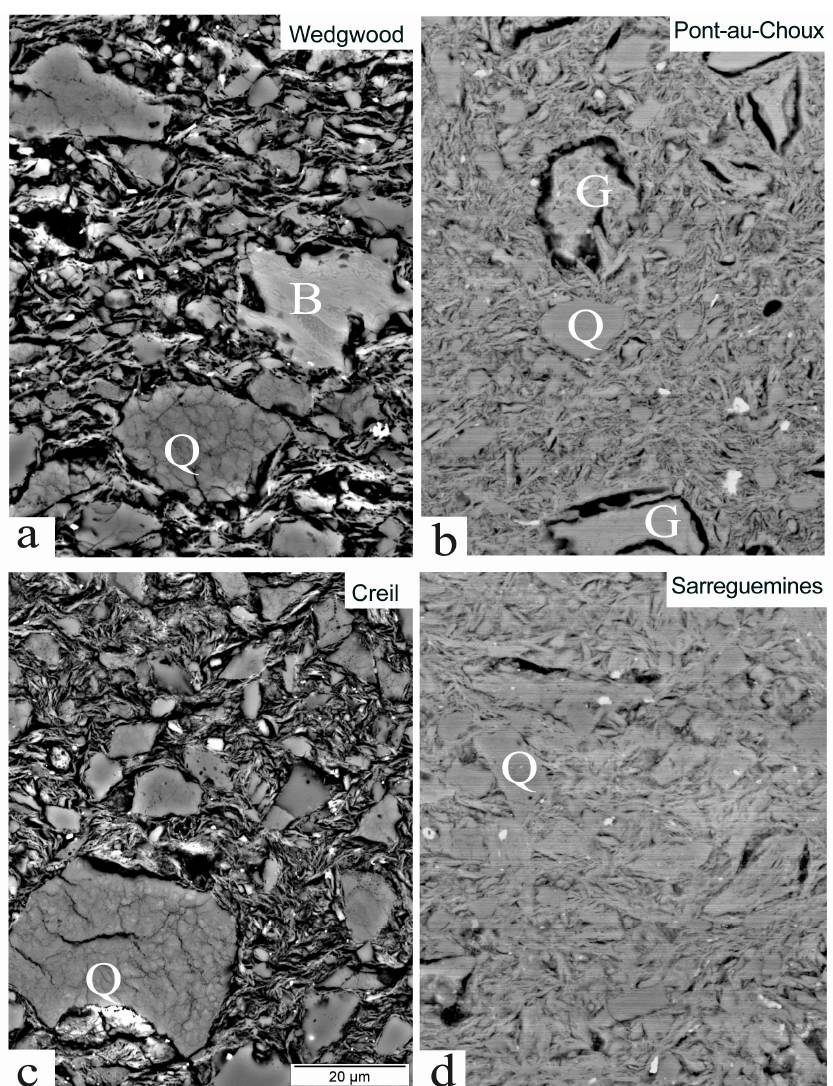
Figure 5. Scanning electron microscope-back scatter detector (SEM-BSE) images of four typical CaO-poor samples from England and France. ( a ) [25] (Sample Wed-2); ( b ) [16] (TBL 18); ( c ) [25] (Creil-2); ( d ) [16] (TBL 2). B = inclusion type B, G = grog, Q = quartz. Same scale for all.